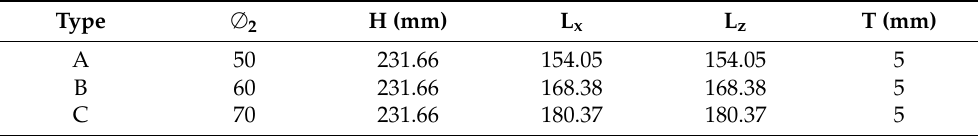
Figure 4. Different 2D plane compositions: ( a ) type A, face-up and overhead composition; ( b ) type B, face-up and overhead composition; ( c ) type C, face-up and overhead composition. Table 2. Three parameters of the honeycomb structure.